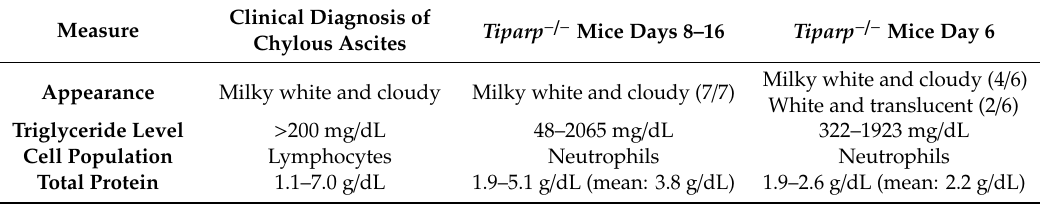
Figure 2. Thirty-day survival study characteristics. ( A ) Kaplan–Meier survival curves indicating the survival rate of 3MC-treated WT ( +/+ ) and Tiparp − / − ( − / − ) mice. Mice were euthanized when body weight loss exceeded 20% of the baseline (day 0) value or if the animal had reached an endpoint as described in the Materials and Methods. ( B ) Daily body weights expressed as a percent of baseline values (i.e., day 0). ( C ) Daily food intake measurements expressed as a gram per gram percentage of daily mouse body weight normalized to baseline values. For B and C, the data represent the mean ± SEM; n = 4–6. ( D ) Representative images of the closed peritoneum and opened peritoneal cavity of WT (left; day 30) and Tiparp − / − mice (right; day 16). Images on the top show an intact peritoneum with fluid accumulation in the 3MC-treated Tiparp − / − mice (right) compared with similarly treated WT mice (left). Images on the bottom show the open abdomen and all tissues in the peritoneal cavity. Reduced epididymal white adipose tissue was observed in the Tiparp − / − mice with remnants of the fluid adhering to the tissues. Table 1. Characteristics of chylous ascites observed from 3MC-treated Tiparp − / − mice. Values for the clinical diagnosis of chylous ascites were adapted from C á rdenas and Chopra (2002) [25]. Values in parentheses indicate the number of observations over the number of total